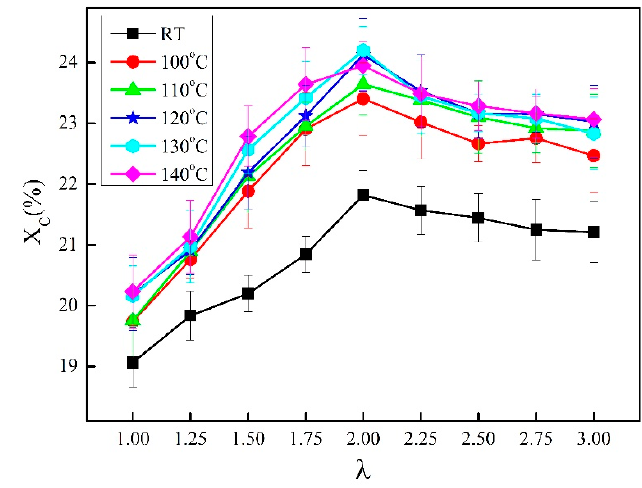
ff erent temperatures and draw ratios.